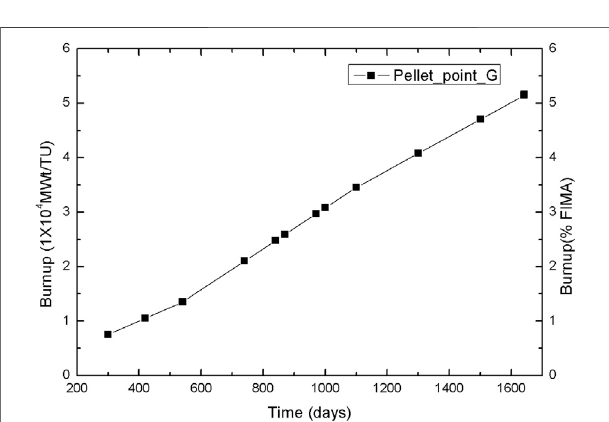
FIGURE 8 | Schematic diagram of fuel rod data extraction points.